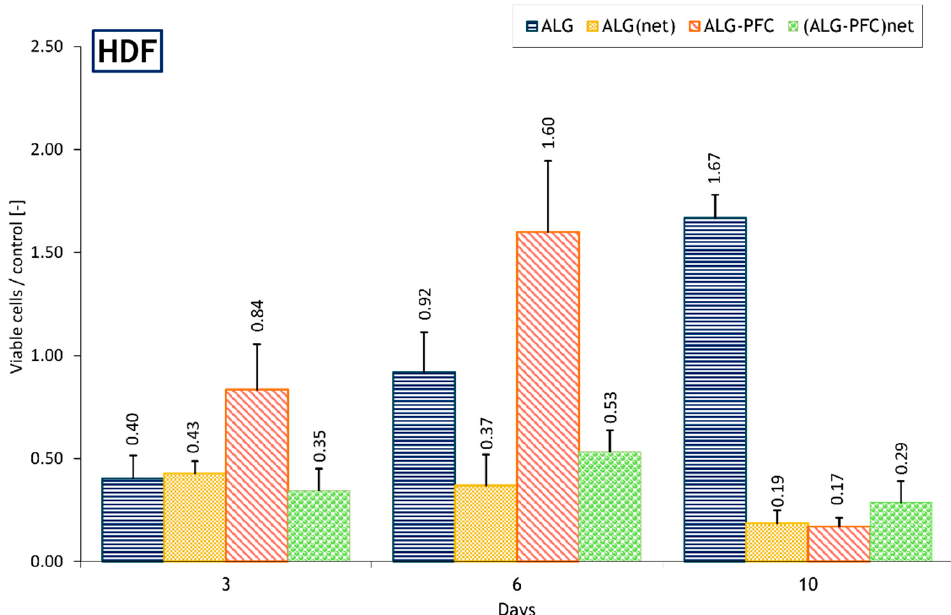
Figure 2. The ratio relative to the control of mitochondrial activity of HDF immobilized on the support with membrane coating represented by formazan production expressed by absorbance during 10-day culture. Key to the symbols: ALG—alginate, ALG net —alginate cross-linked, ALG- PFC—alginate–perfluorooctyl, (ALG-PFC) net —alginate–perfluorooctyl cross-linked. The values are presented as mean ± SD ( n = 6).